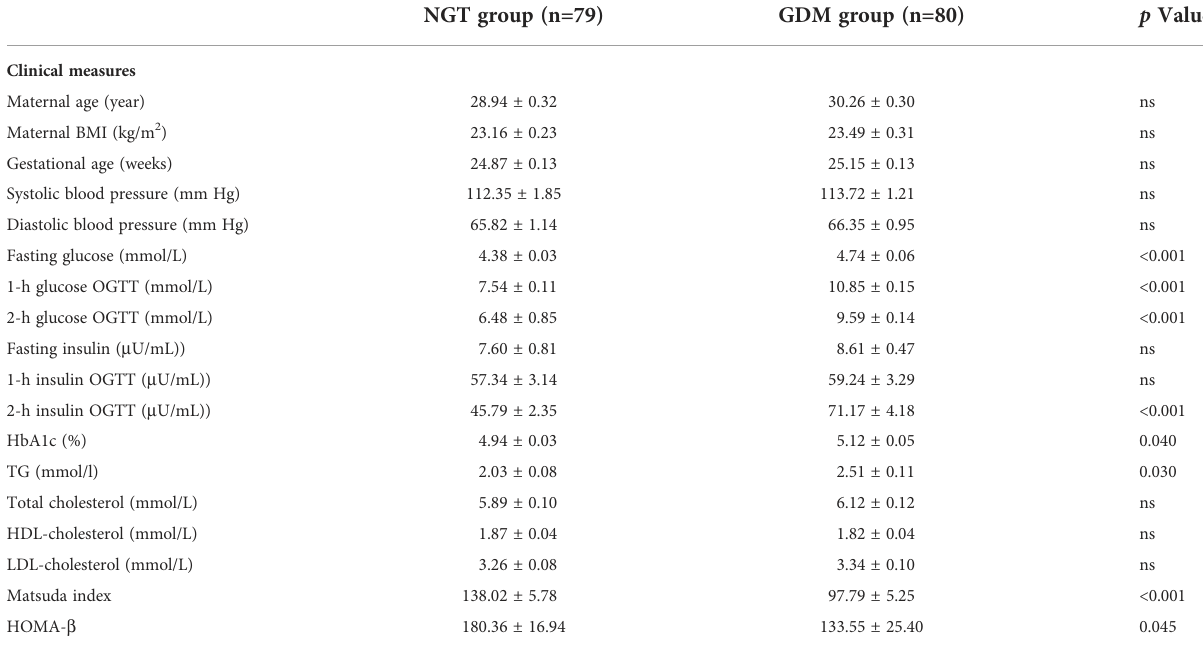
TABLE 1 Baseline characteristics in women with GDM and women with